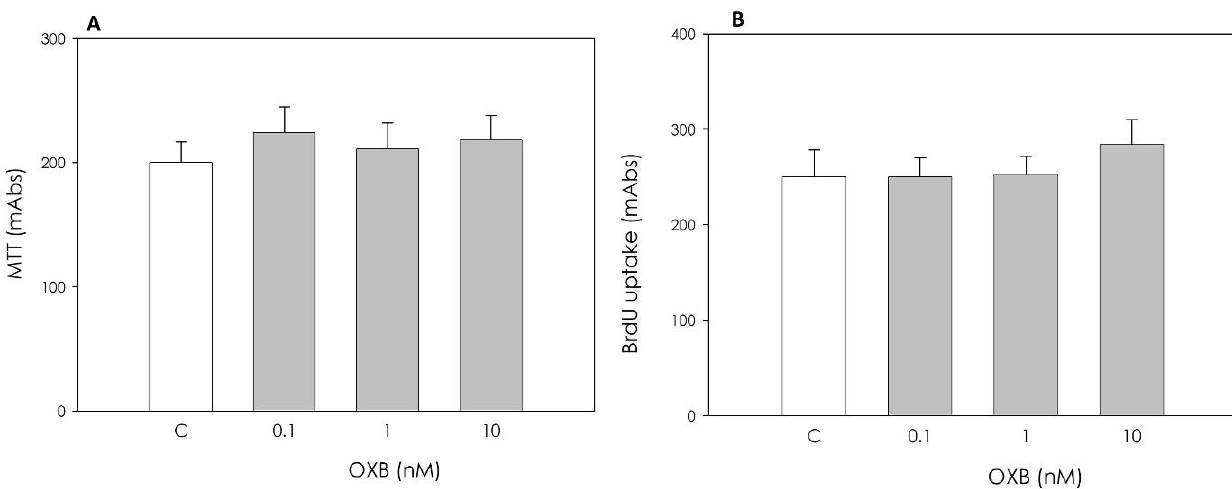
Figure 2. Effect of the 48 h treatment with orexin B (OXB; 0.1, 1 and 10 nM) on swine granulosa cell viability, evaluated by MTT test ( A ), and on granulosa cell proliferation evaluated using 5-bromo-2′-deoxyuridine (BrdU) incorporation assay test ( B ). Data, expressed as milliAbsorbance (mAbs), represent the mean ± SEM of six replicates/treatment repeated in five different experiments .